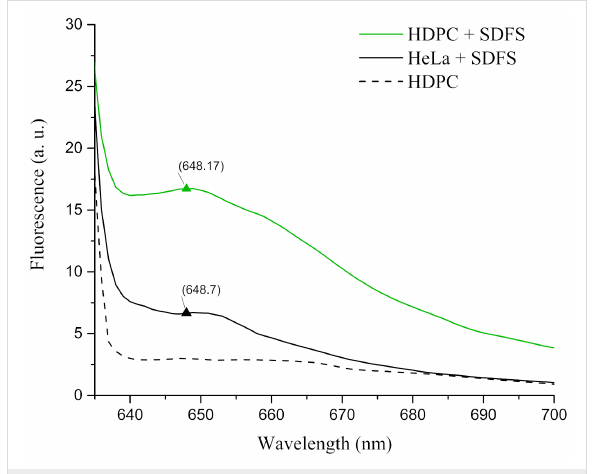
Figure 3: Emission spectra of SDFS activity on total cellular RNA. The green line represents a spectrum of SDFS incubated with total HDPC RNA. The black line is a spectrum of SDFS incubated with total HeLa cells RNA. The black dotted line is a spectrum of total HDPC RNA in- cubated in the presence of malachite green dye but without